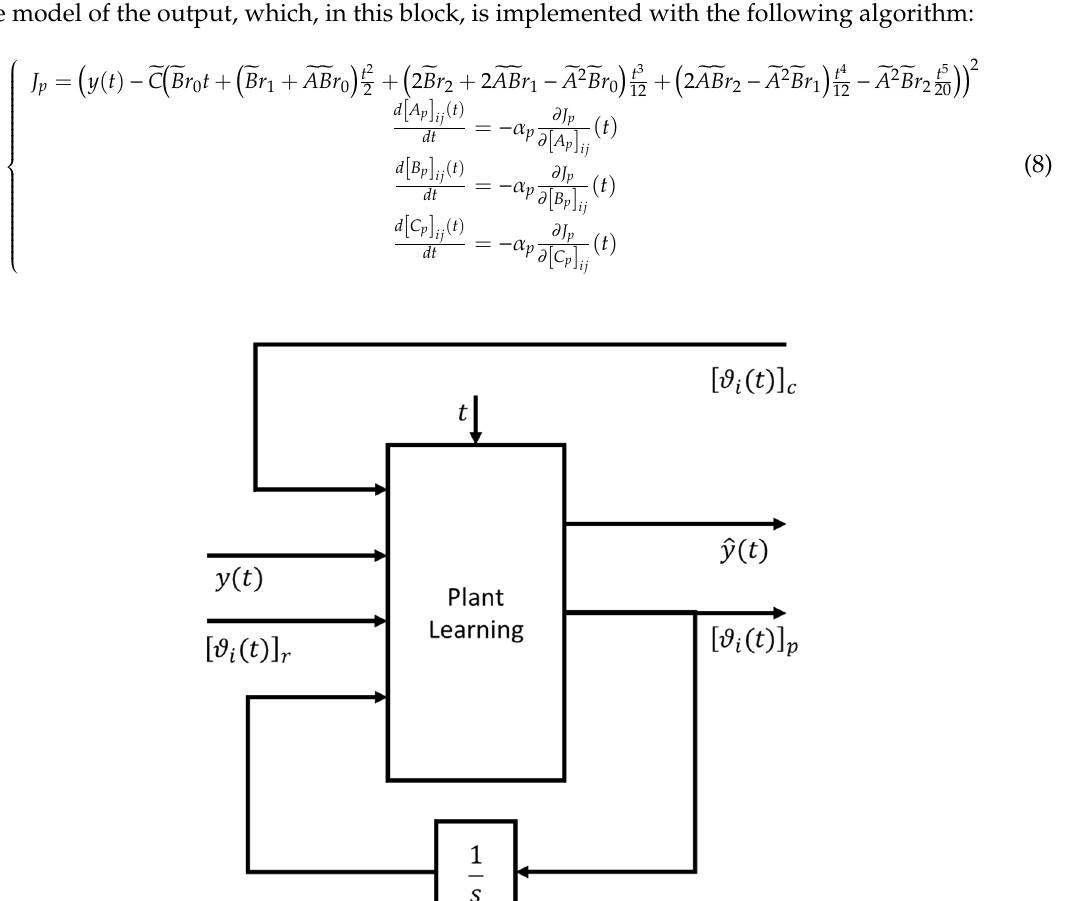
Figure 6. Schematic representation of the implementation reported in Equation (8).